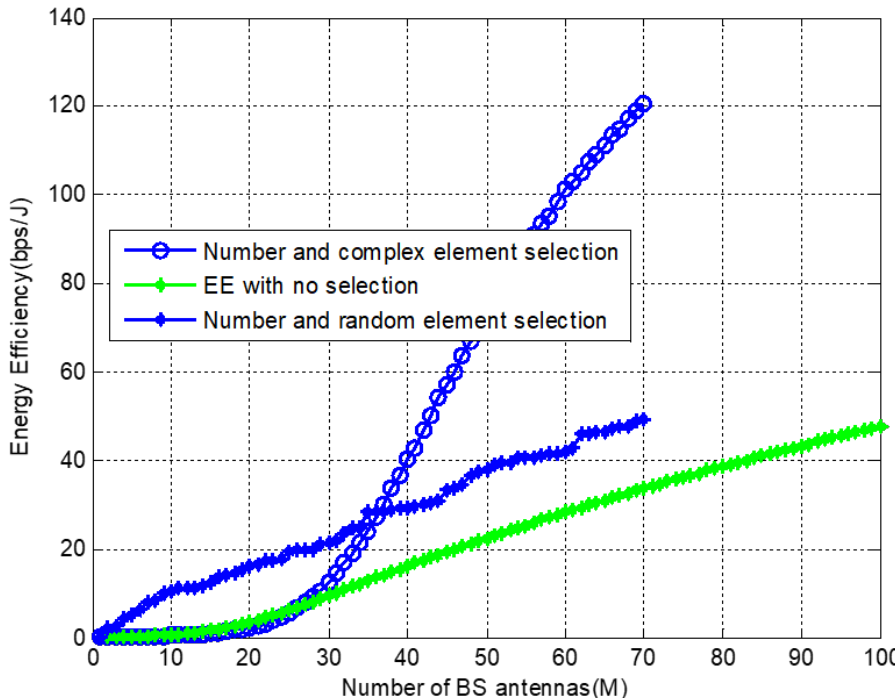
Figure 10. Energy efficiency evaluation with random and complex selection at f = 38 GHz and M = 100.